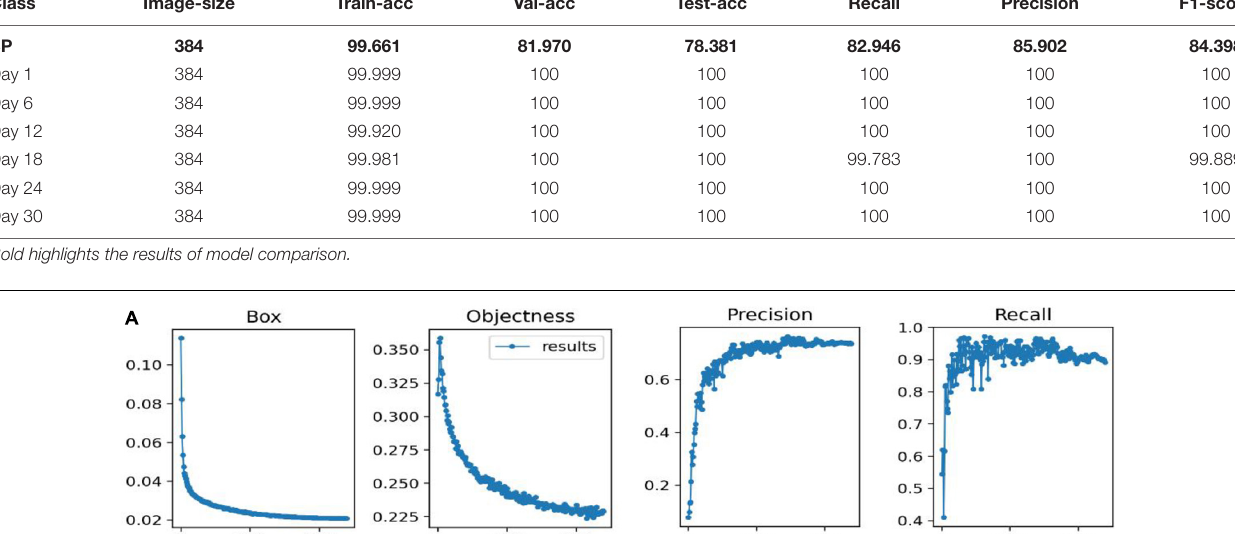
TABLE 2 | Classification model results of different growth stages of lettuce based on VOLO-D1. Class Image-size Train-acc Val-acc Test-acc Recall Precision F1-score